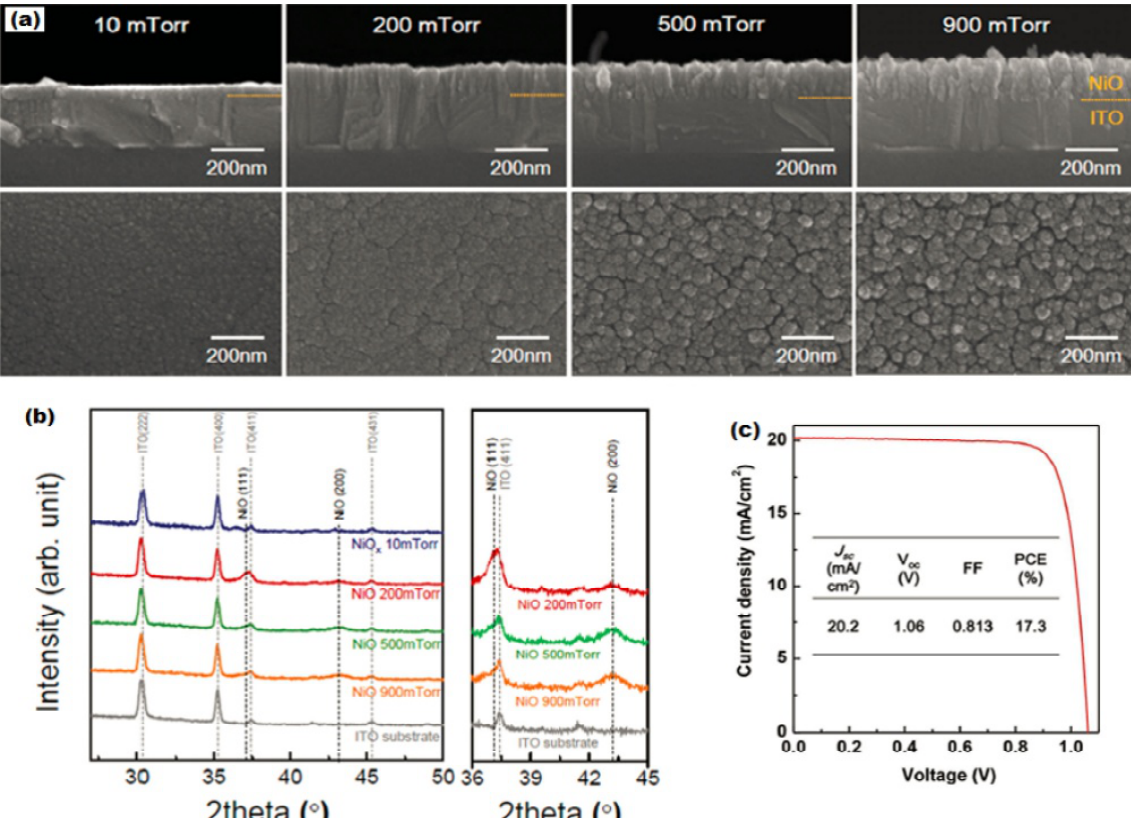
Fig. 5. Structure (ITO/NiO/CH NH PbI /PCBM /LiF/Al) and performance of device with inorganic HTM: (a) 3 3 3 SEM images (b) XRD images of HTL at different oxygen partial pressure and (b) J-V curve of the device at optimum condition (that is at 200 mTorr oxygen partial pressure, 150 nm NiO thickness), reprinted with permission from J.H. Park, J. Seo, S. Park, S.S. Shin, Y.C. Kim, N.J. Jeon, H.W. Shin, T.K. Ahn, J.H.